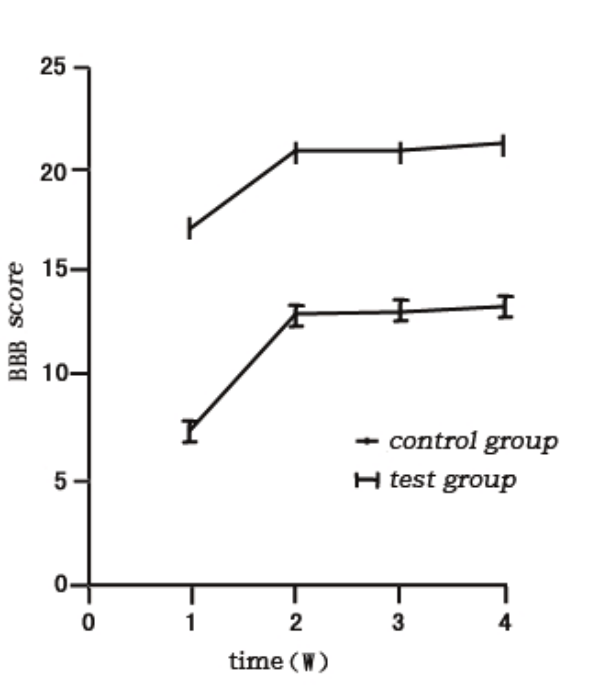
FIGURE 4 - The BBB score of test group and control group after paraplegia.